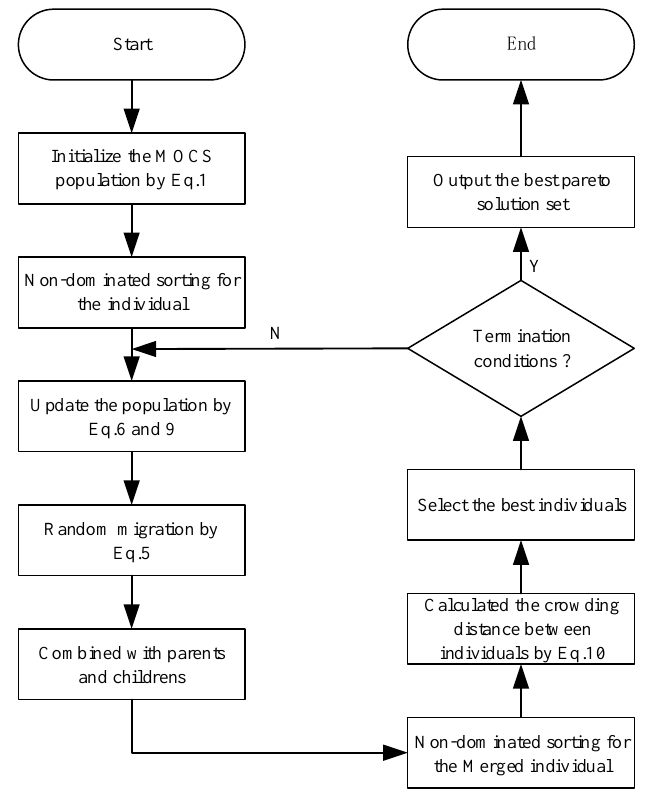
Figure 1. Flowchart of the IMOCS.